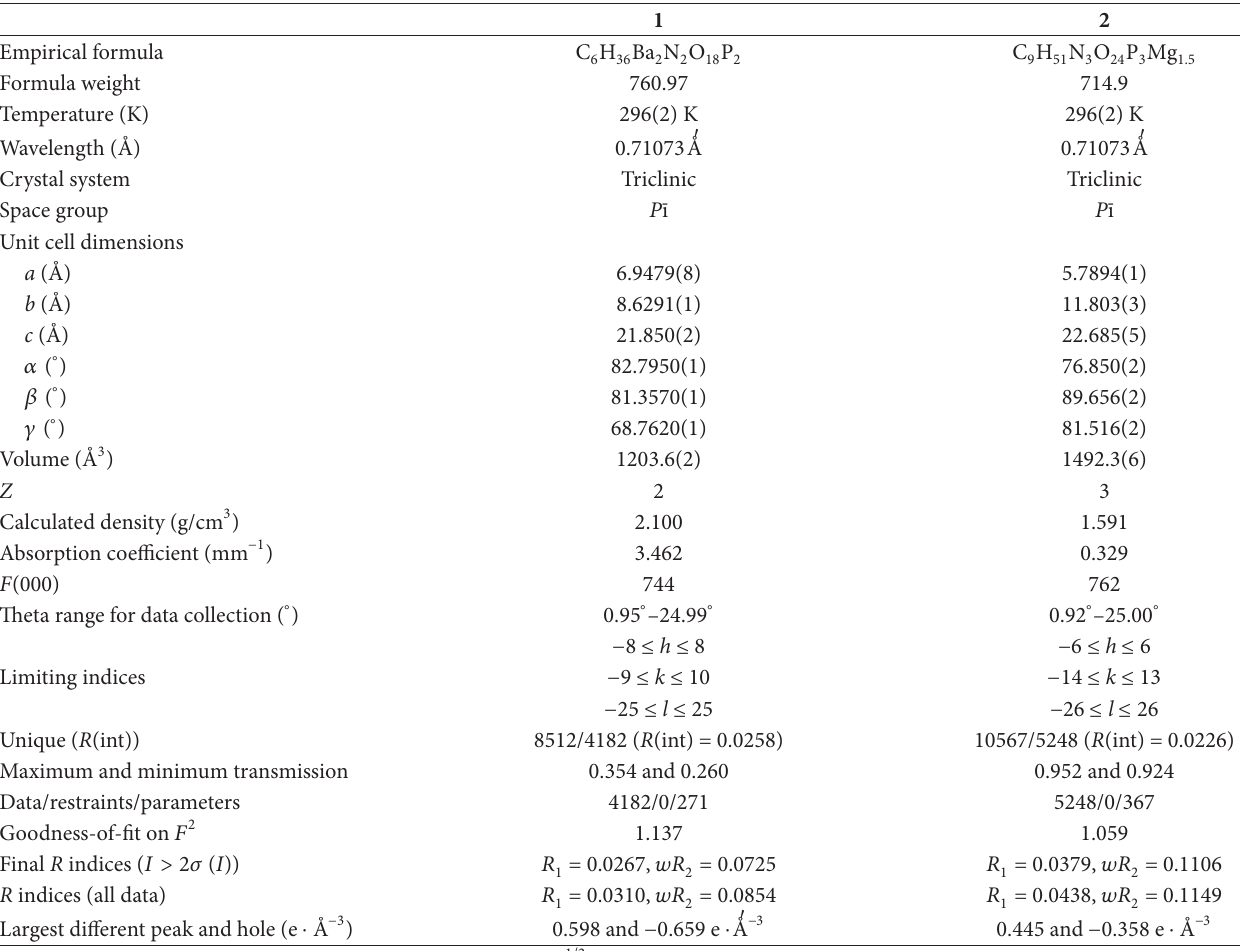
T 1: Crystallographic data for 1 - 2